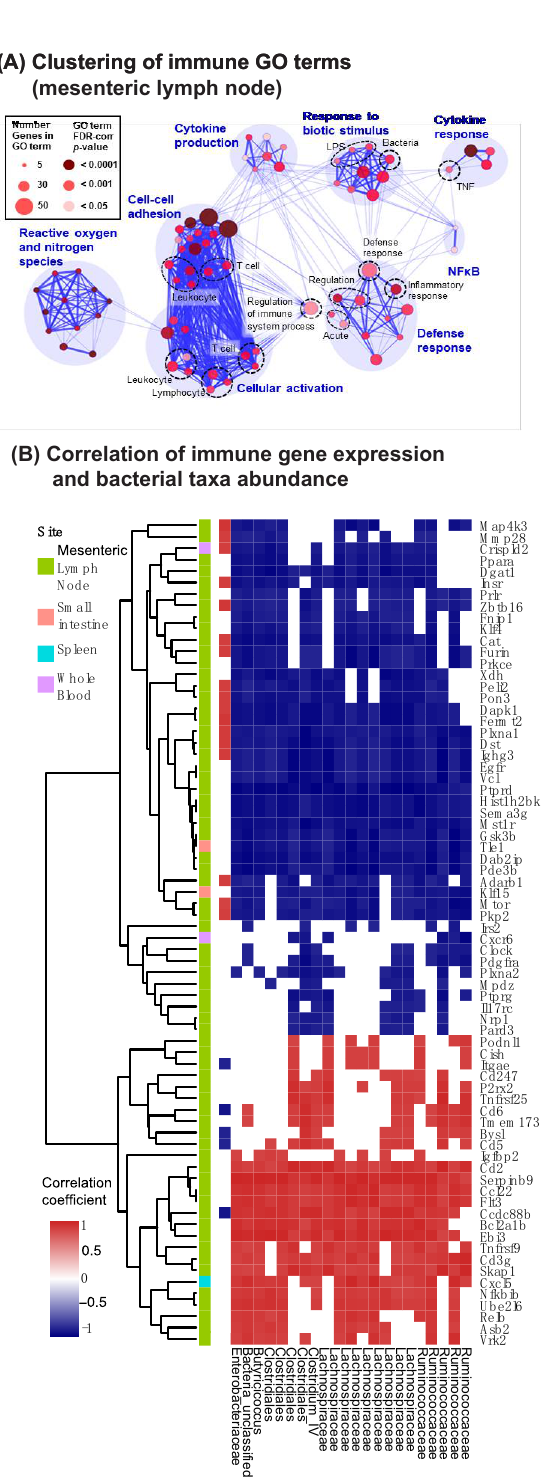
Figure 4. Expression of innate immune response genes is associated with differential abundance of particular bacterial taxa. BALB/c mice were orally treated with vancomycin for 7 days, followed by 1 day without antibiotic treatment before feces and tissues were harvested for bacterial 16S rRNA gene sequencing and host RNA-sequencing. ( A ) Visualization of immune pathways altered by vancomycin treatment in the mesenteric lymph node. Gene set enrichment analysis was used to identify GO terms enriched in the mesenteric lymph nodes RNA-sequencing dataset (see Figure